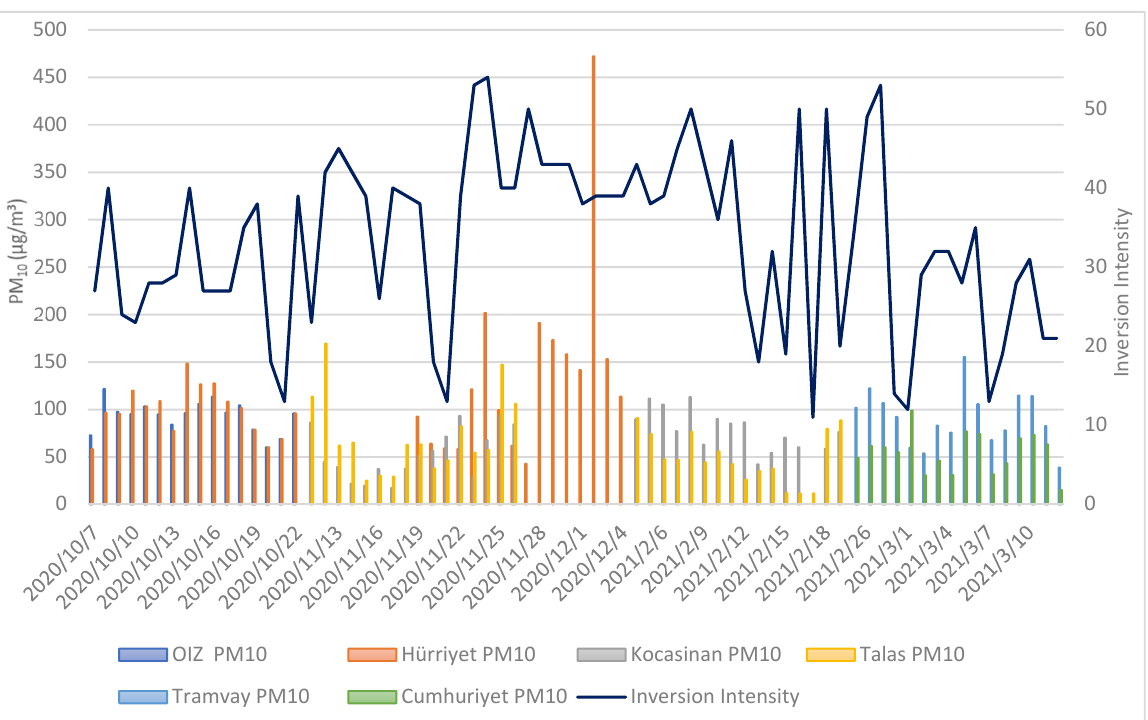
and spring periods, are presented in Figures 4 and 5, respectively.